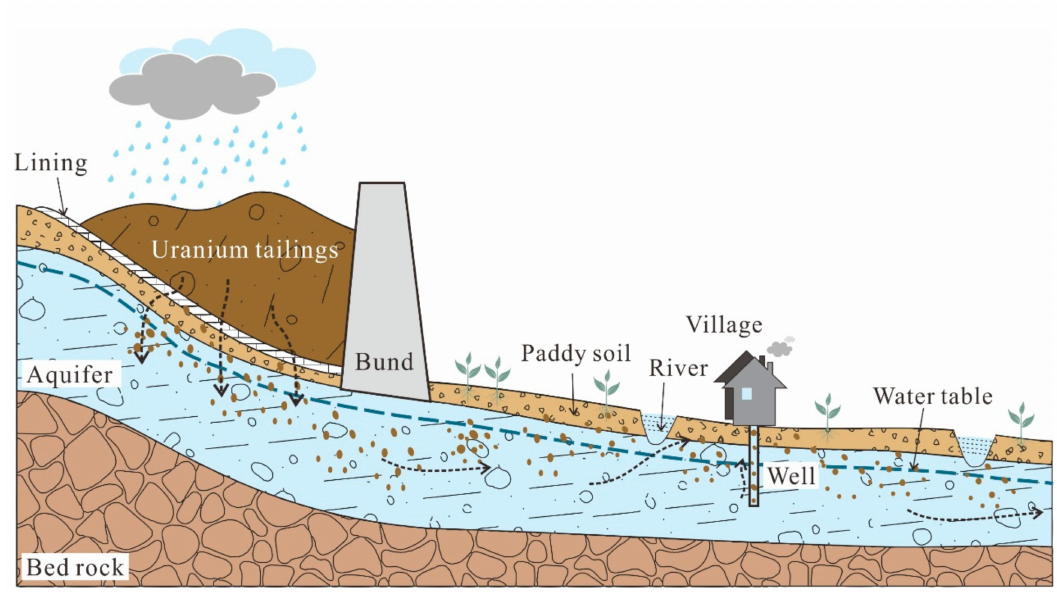
Figure 1. Conceptual model of U cycling around a U mill tailings